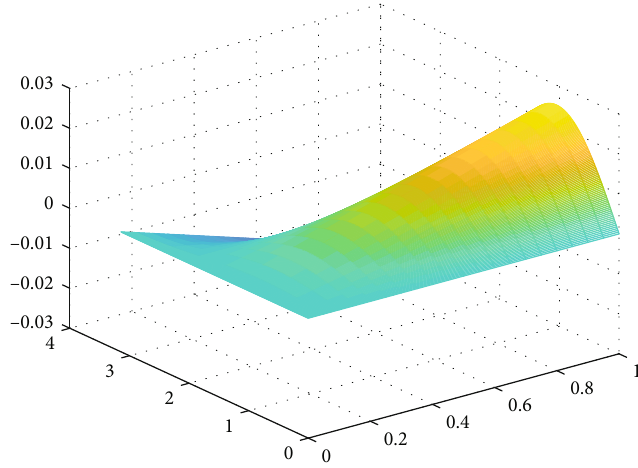
Figure 5: Solution of Test 3 when α = 0 : 8 .